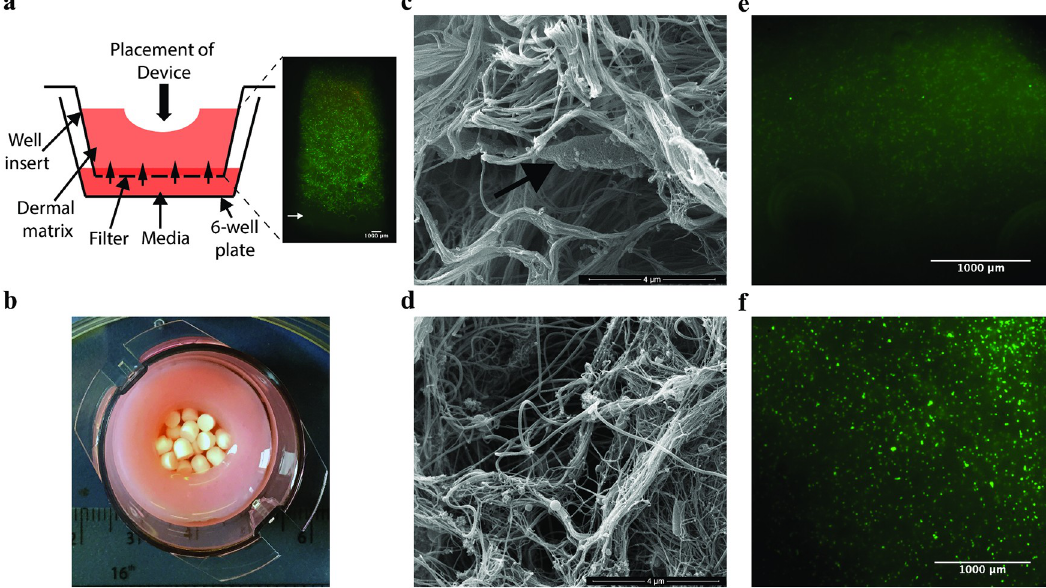
Fig 1. The IVM model system is such that actives can be added to the surface of the model or the media and the matrix is comparable to that of soft tissue. (a) Schematic of the IVM model system and live dead staining of the fibroblasts in cross-section through the model after two weeks maintenance in tissue culture. Green spots indicate live cells, red indicates dead cells, as cells are viable in this image there are very few red spots. (b) Image of the IVM model from above showing the central void packed with CSB with measurements for scale. (c) SEM image of the IVM model with a fibroblast indicated in the collagen matrix by a white arrow (d) compared to DFAN, a sample of debrided tissue. Micrographs of live dead stained sections of representative control models which were not inoculated with bacteria and to which (e) unloaded CSB or (f) gentamicin loaded CSB were added in parallel to inoculated models. There was no evidence of toxicity of the gentamicin or calcium